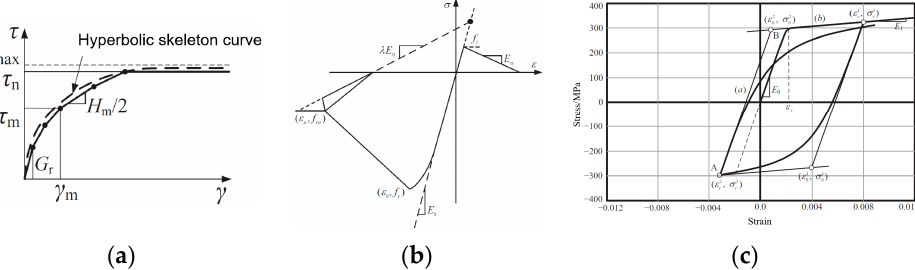
Figure 6. Constitutive models of materials. ( a ) The constitutive model of sand soil; ( b ) modified Kent–Park model for concrete; ( c ) Menegotto–Pinto model for steel rebar.